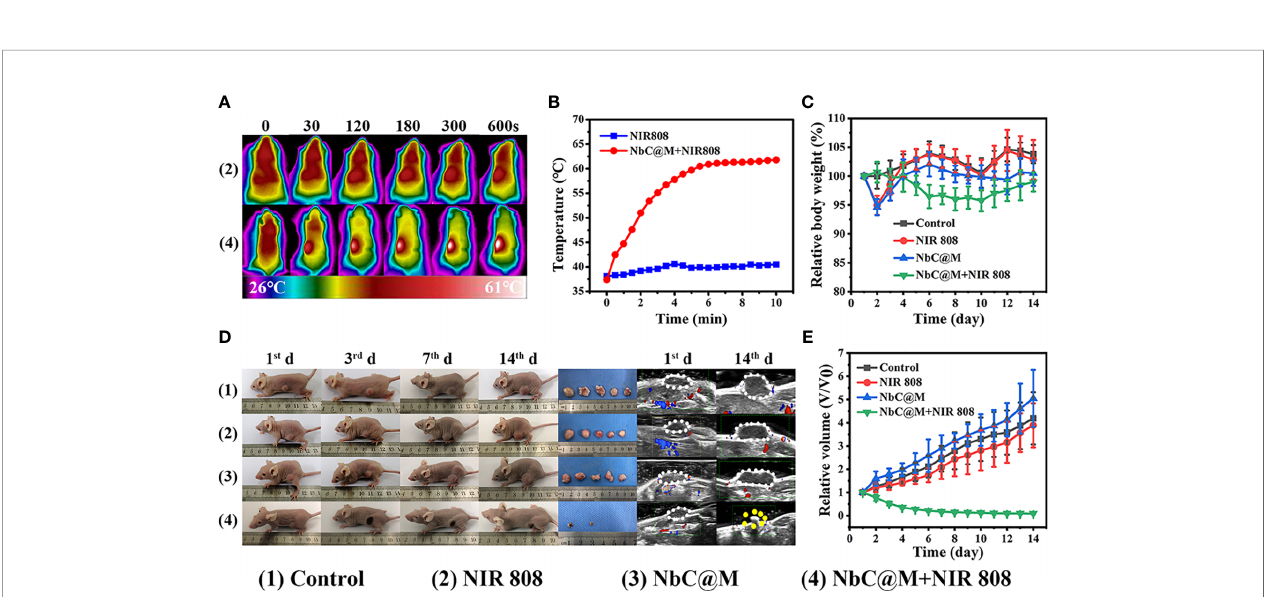
FIGURE 5 | In vivo phototherapy study. (A) Photothermal images of HepG2 tumor-bearing mice under NIR irradiation (808 nm, 1W/cm 2 ) and (B) corresponding temperature variation at tumor sites under NIR irradiation. (C) Quantitative measurements of relative body weight after different treatments during 14 days. (D) Representative photographs of mice, tumors and ultrasound image during the treatments. (E) Relative tumor volume after different treatments during 14